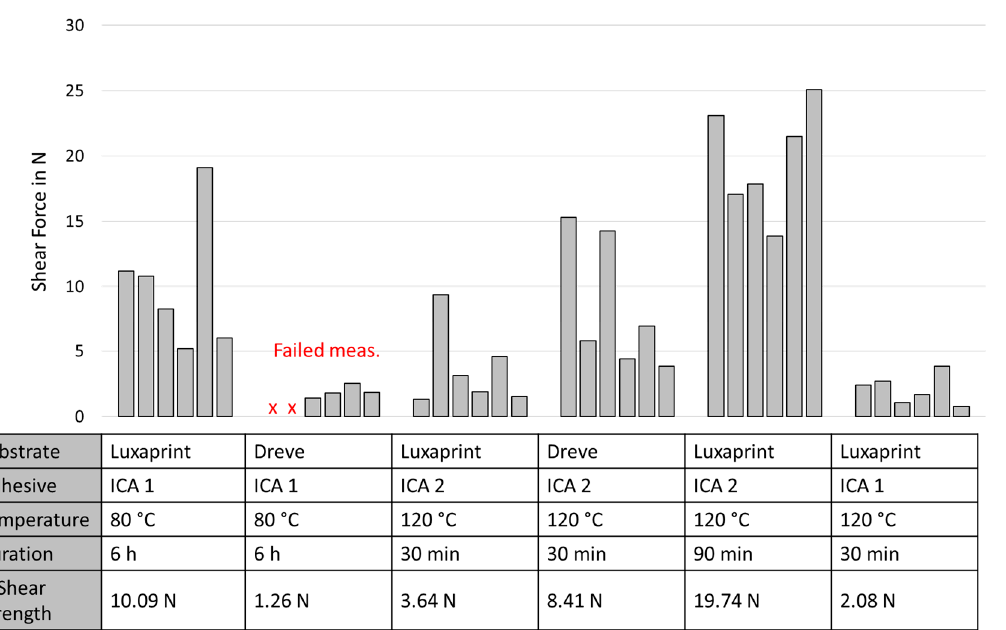
Figure 15. Soldering of pressure sensor BMP388 with SnBi solder at 180 °C (substrate: Luxaprint 3D mold). Aerosol jet printed Ag structures after electroless copper plating (15 min) ( a ). Aerosol jet printed Ag structures after electroless copper plating (15 min) and electroless plating with Ni/Au surface finish ( b ).